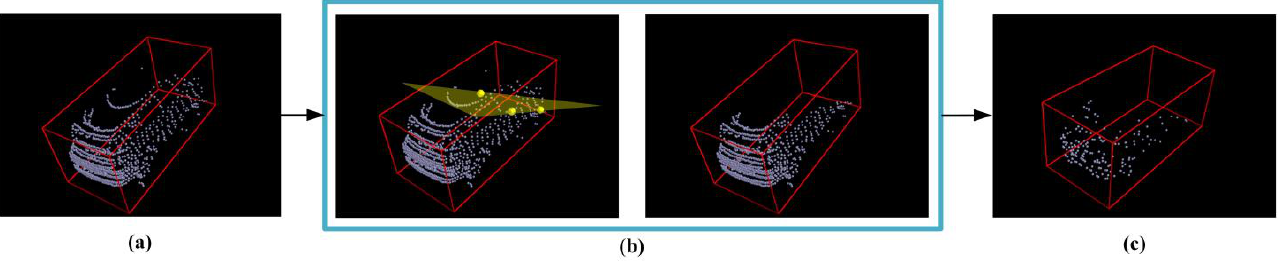
Figure 3. The procedure of point cloud mask. ( a ) is the original point cloud of a car, ( b ) is an example of simulated “External - occlusion”, ( c ) is an example of simulated “Signal miss”.